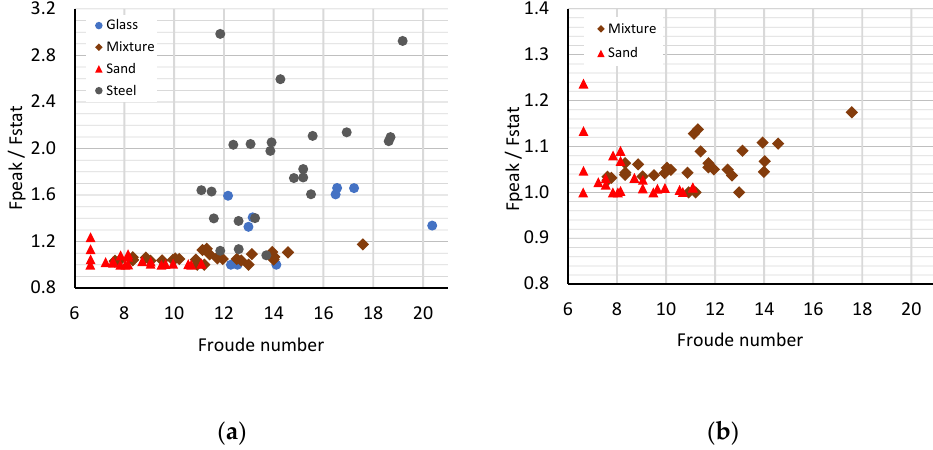
Figure 7. F peak / F stat ratio for different Froude numbers for impacts on a rigid barrier: ( a ) for all materials, and ( b ) for the natural material sand and the mixture.